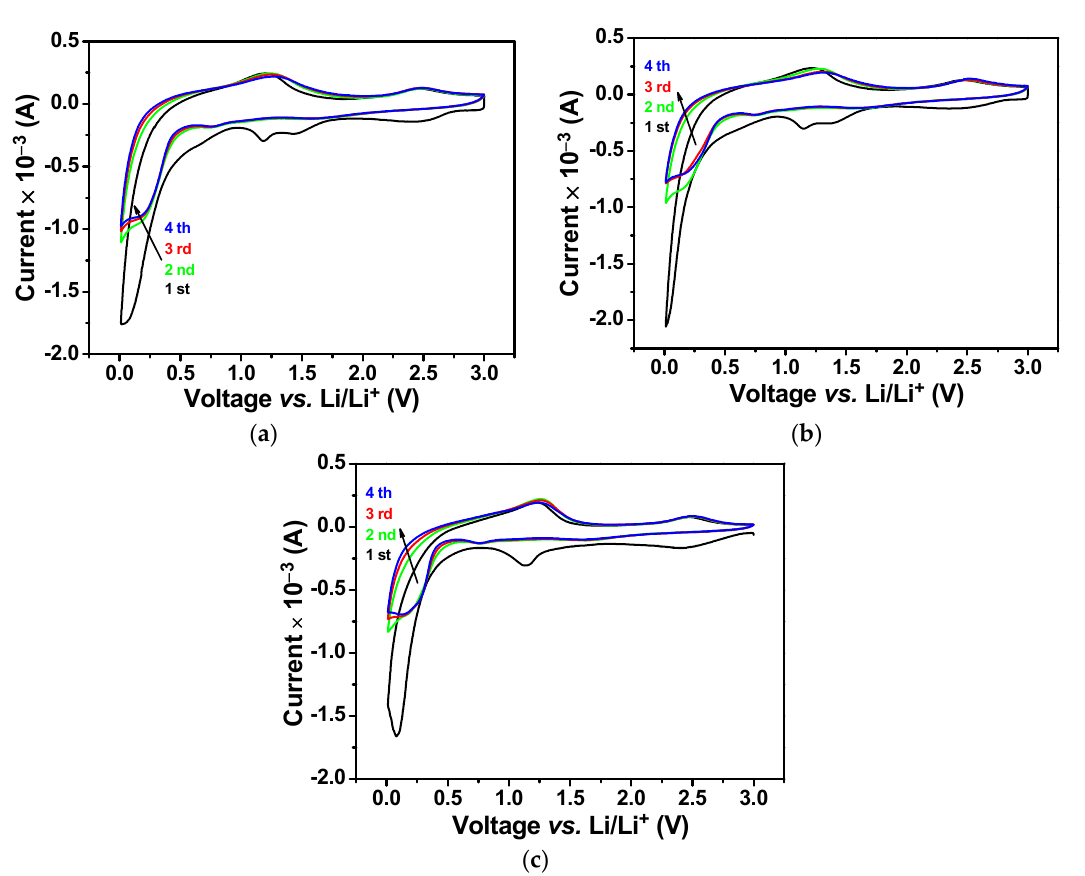
Figure 7. Cyclic voltammetry curves of ( a ) MnO 2 -TiO 2 -carbon-47.28%, ( b ) MnO 2 -carbon-40.15% composite and ( c ) MnO 2 -NPs tested in the initial four charge/discharge cycles at a scan rate of 0.2 mV s − 1 between 0.01 and 3 V (vs. Li/Li + ). The charge/discharge curves of the MnO 2 -TiO 2 -carbon-47.28%, MnO 2 -carbon-40.15%, TiO 2 -carbon nanofiber and MnO 2 -NPs electrodes are shown in Figure 8. The first discharge and charge capacities of MnO 2 -TiO 2 -carbon-47.28% compo-